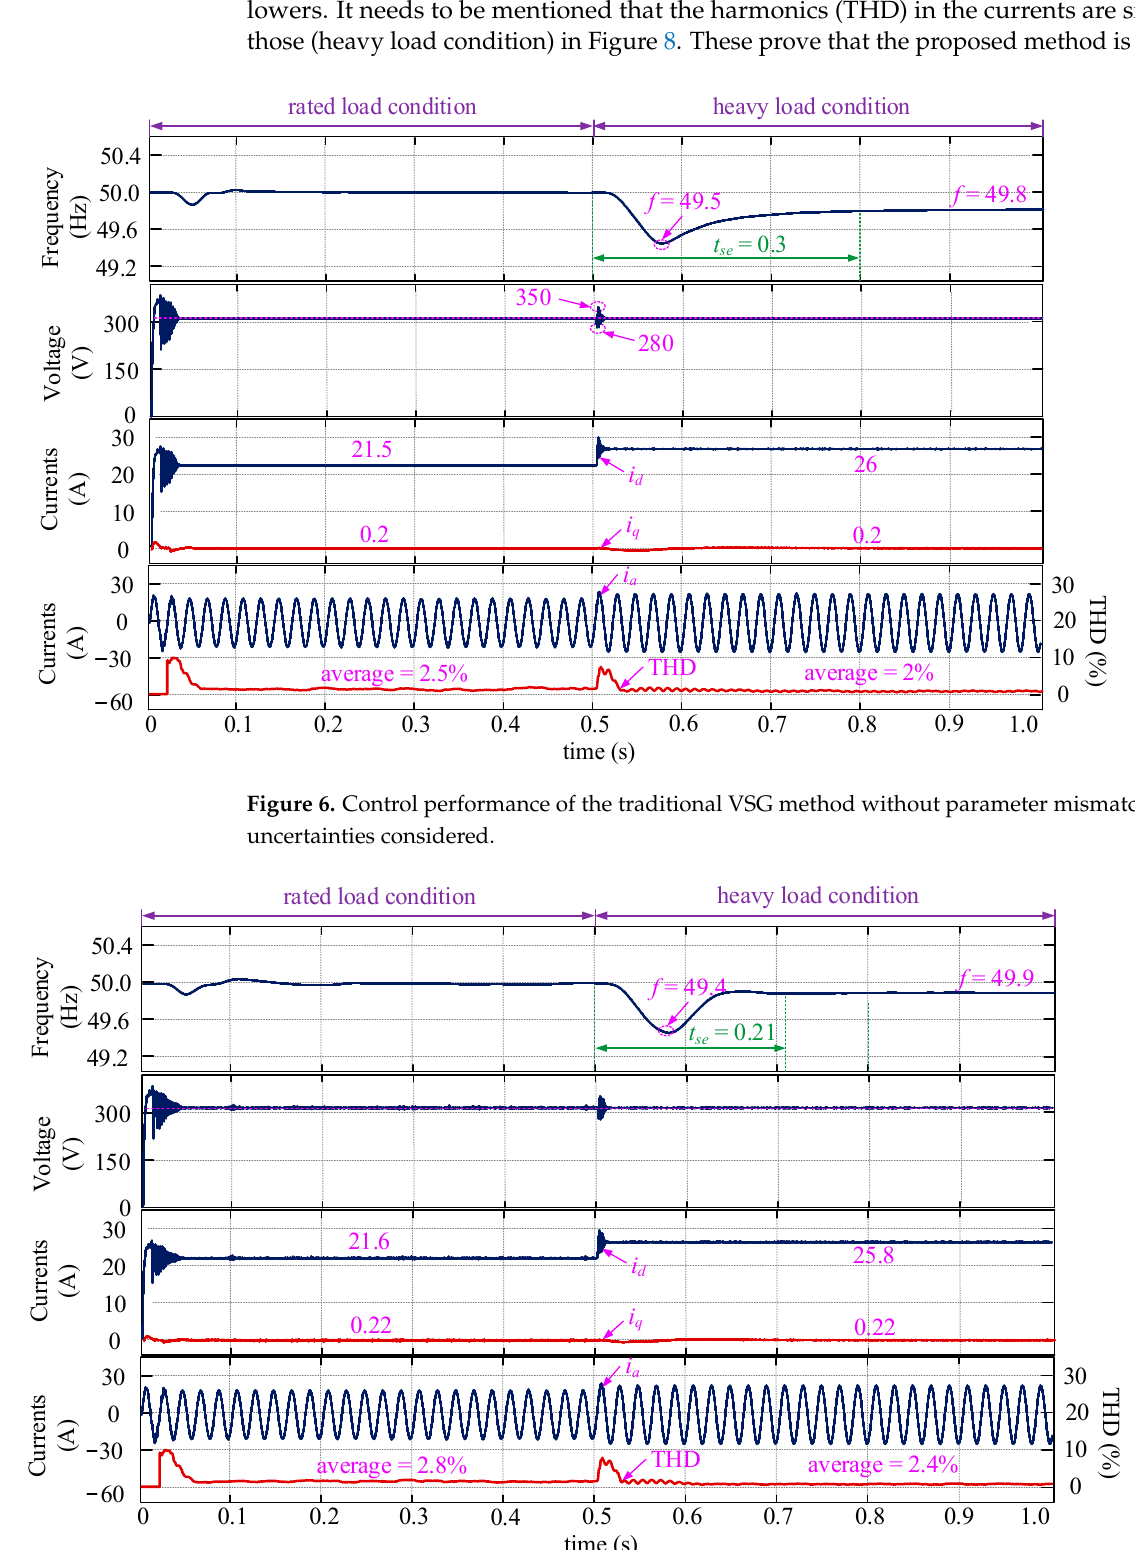
Figure 7. Control performance of the improved VSG method without parameter mismatch and EV uncertainties considered.